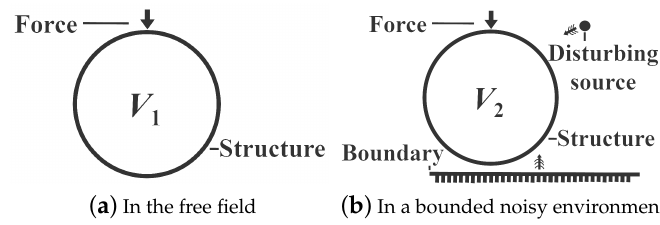
Figure 1. The vibrational behavior of the structure.